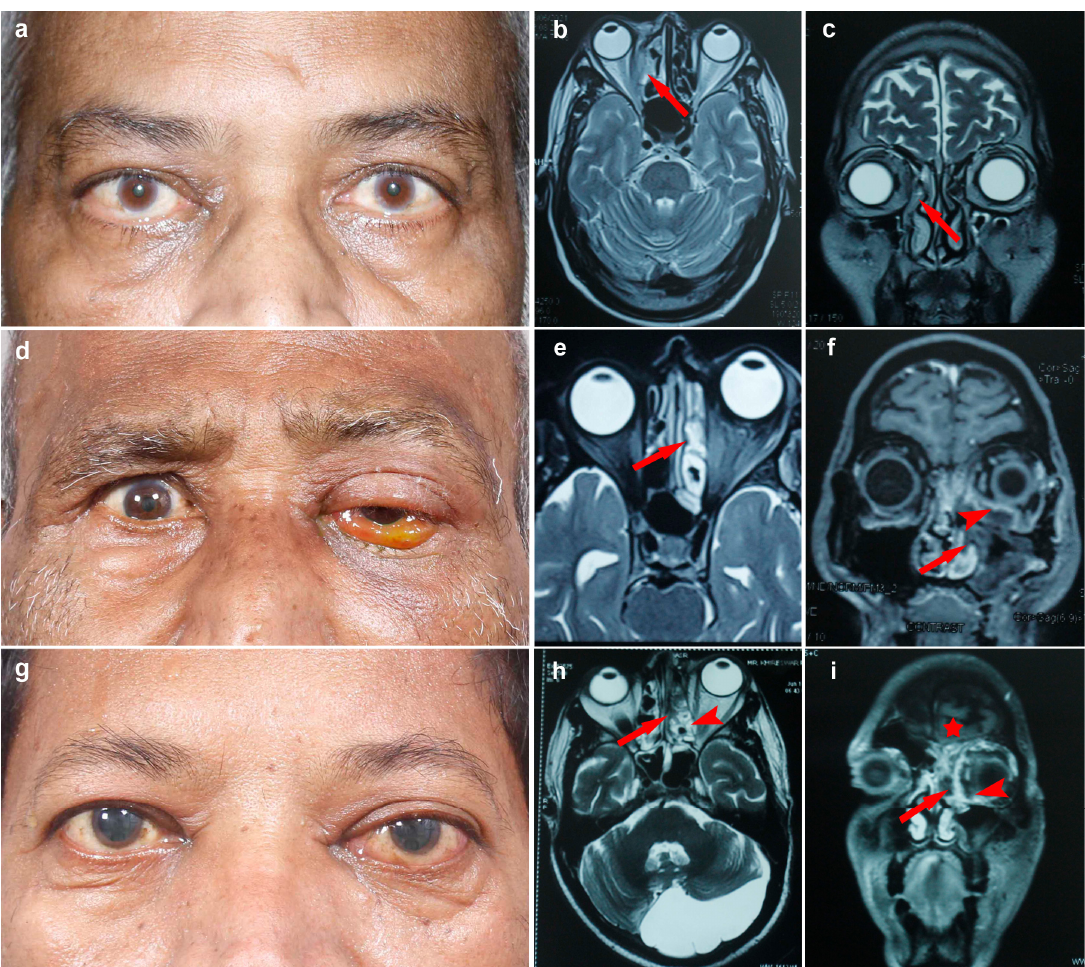
Figure 2. Mild Disease ( a – c ): 64 years male with lid edema, mild proptosis, BCVA 20/20 in right eye ( a ). T2W MRI images ( b , c ) show thickening of ethmoid sinus (red arrow) without orbital involvement. Moderate Disease ( d – f ): 67 years male patient with redness, lid edema, proptosis, BCVA 20/40 in the left eye ( d ). T2W and T1W MRI ( e , f ) images showing ethmoid and maxillary sinusitis (red arrow) with focal inferomedial orbital involvement (red arrowhead). Severe Disease ( g – i ): 57 years male with severe headache with pain, redness, proptosis, restricted ocular movements, BCVA PL+/PR inaccurate in left eye ( g ). T2W and T1W MRI ( h , i ) images showing pansinusitis (red arrow) with diffuse orbital involvement (red arrowhead) and focal brain involvement (red